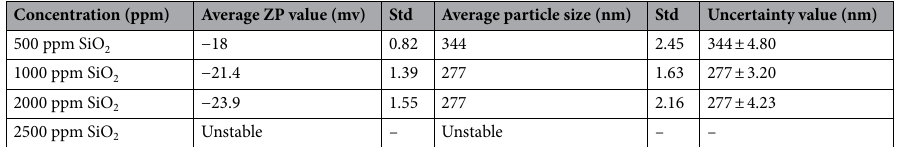
Table 14. ZP and DLS results of OLSHW with uncertainty in the presence of divalent ions with various NPs concentrations at pH = 8.